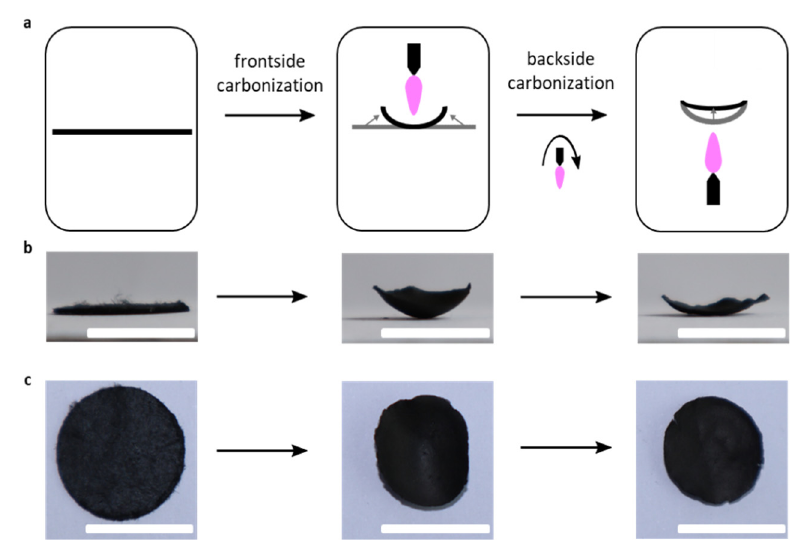
Figure 3. ( a ) Illustration of a two stepped plasma-jet carbonization, during which the nonwoven bend towards the plasma jet. ( b ) Photographs of the side-profile and ( c ) the top-profile of pristine, front carbonized and subsequently back-carbonized nonwoven. The scale bars indicate 10 mm.